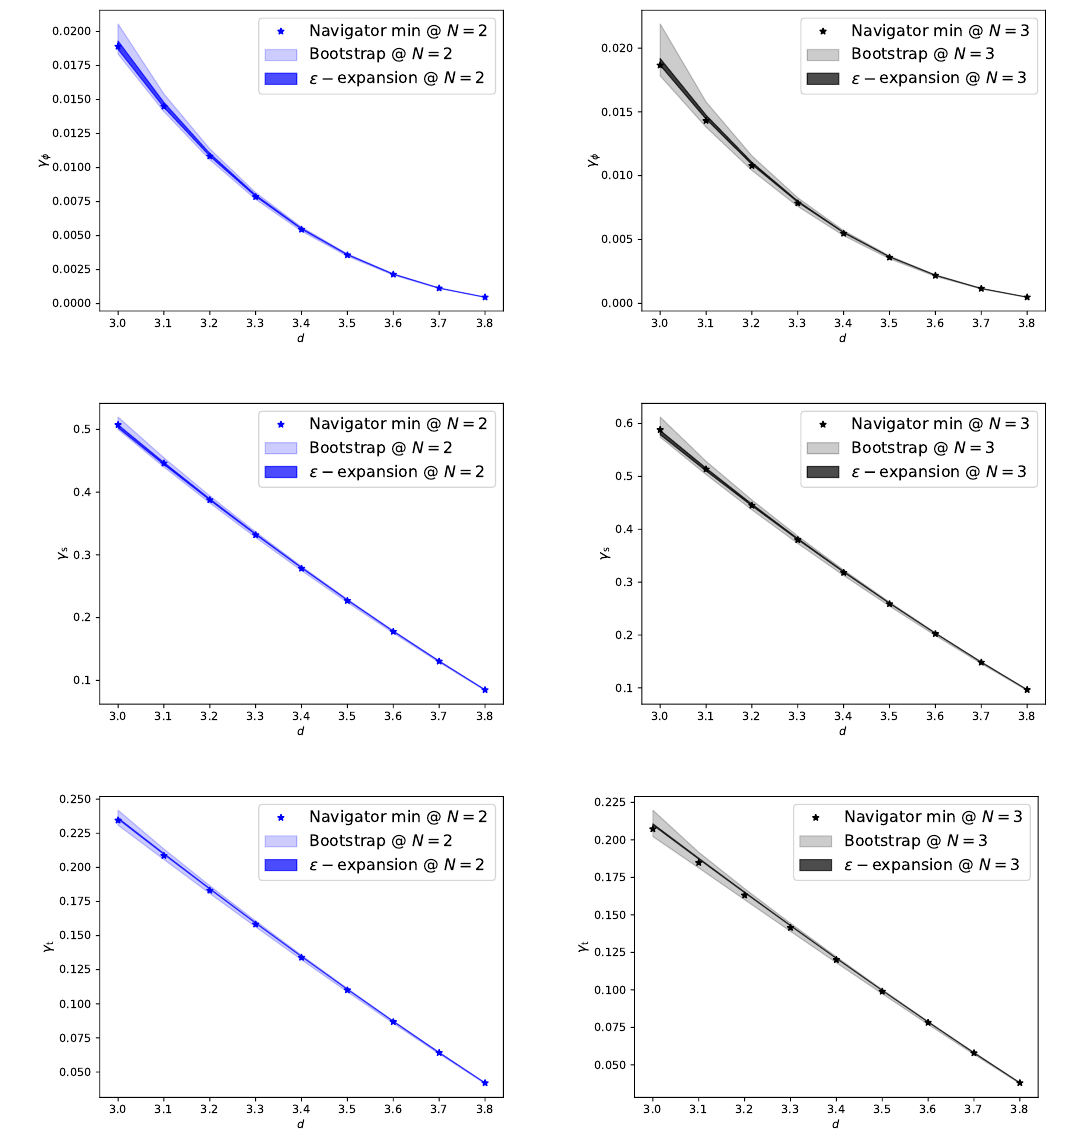
Figure 4: γ φ , γ and γ as functions of d for N = 2,3, as determined by both the con- s t formal bootstrap with the help of the navigator function, and from the resummation of 6-loop ε